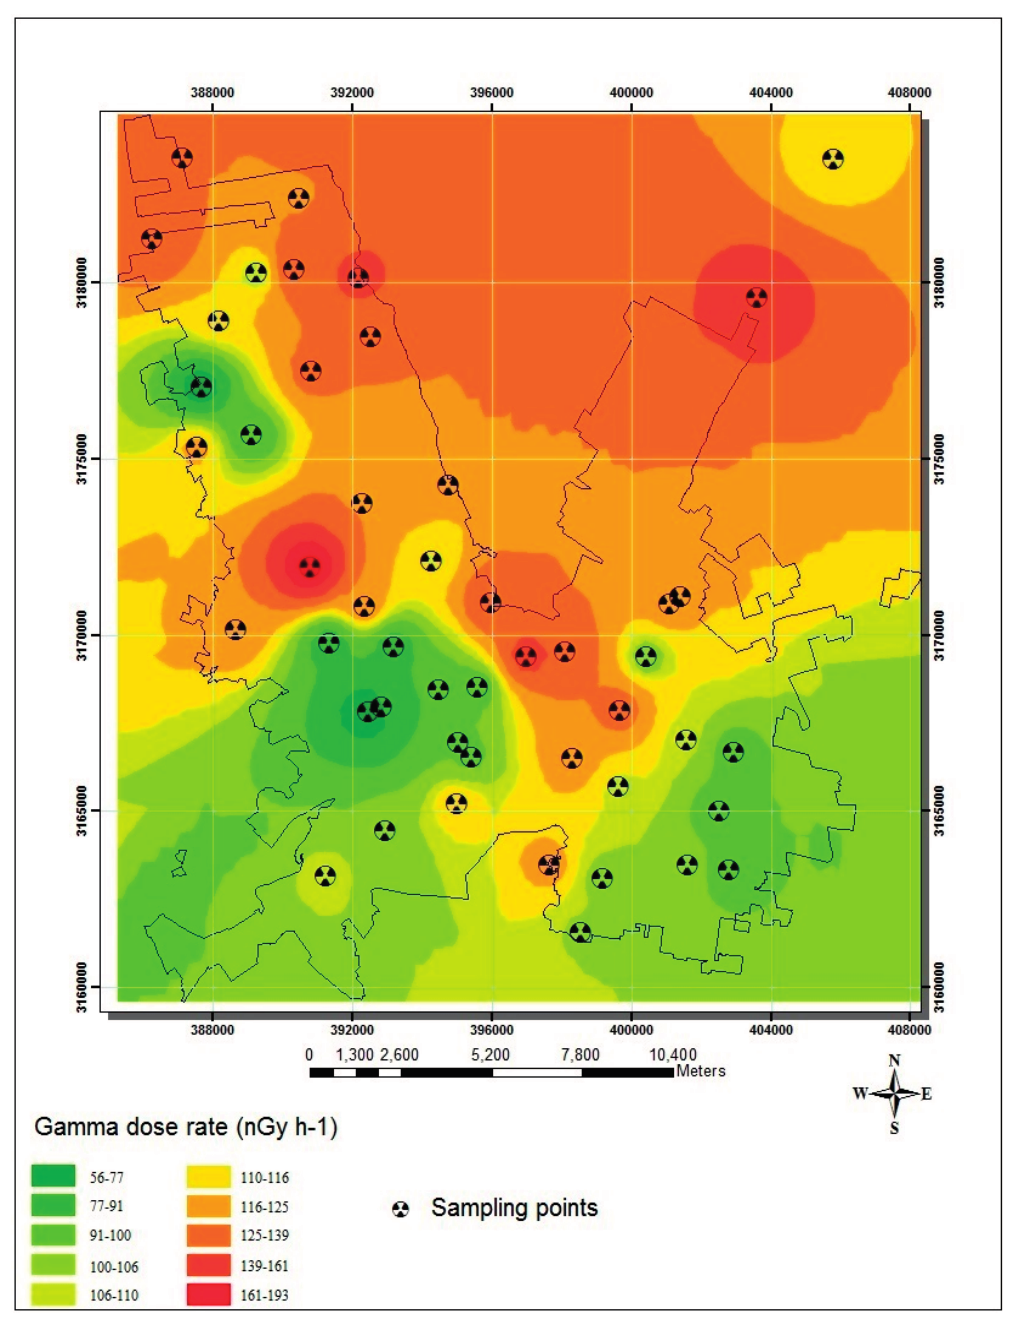
Figure 4. Spatial distribution of absorbed gamma dose rates calculated from the soil activity concentrations in Chihuahua